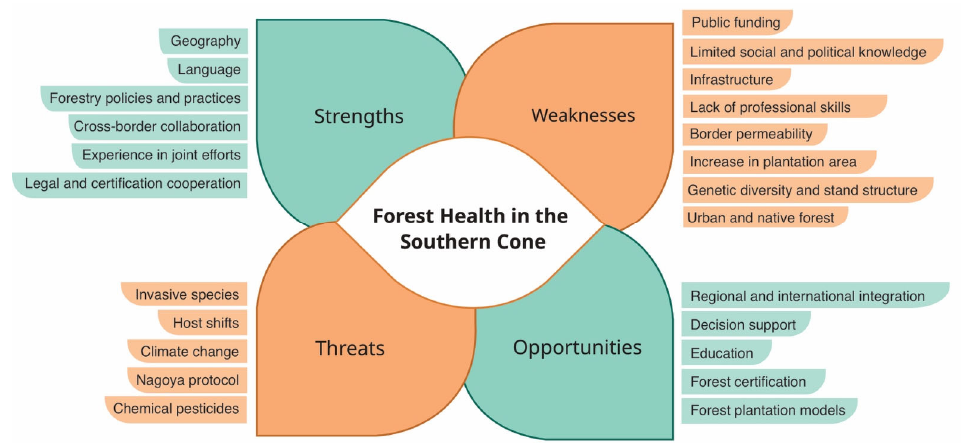
Figure 3. Summary of strengths, weaknesses, threats, and opportunities identi fi ed across the South- ern Cone of South America (Argentina, Brazil, Chile, and Uruguay), as related to current and emerging forest threats.